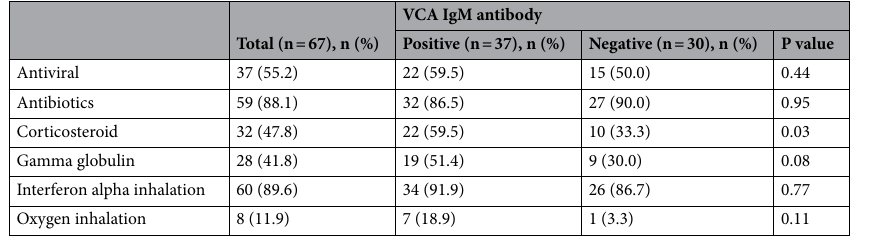
Table 3. Treatments of Epstein–Barr virus (EBV)/severe acute respiratory syndrome coronavirus 2(SARS- CoV-2) coinfection and SARS-CoV-2 infection alone